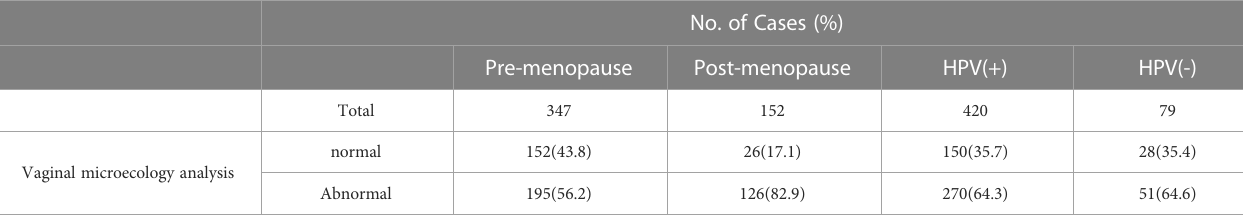
TABLE 7 Vaginal microecology analysis results for women with ASC-US according to menopause state and HPV result.